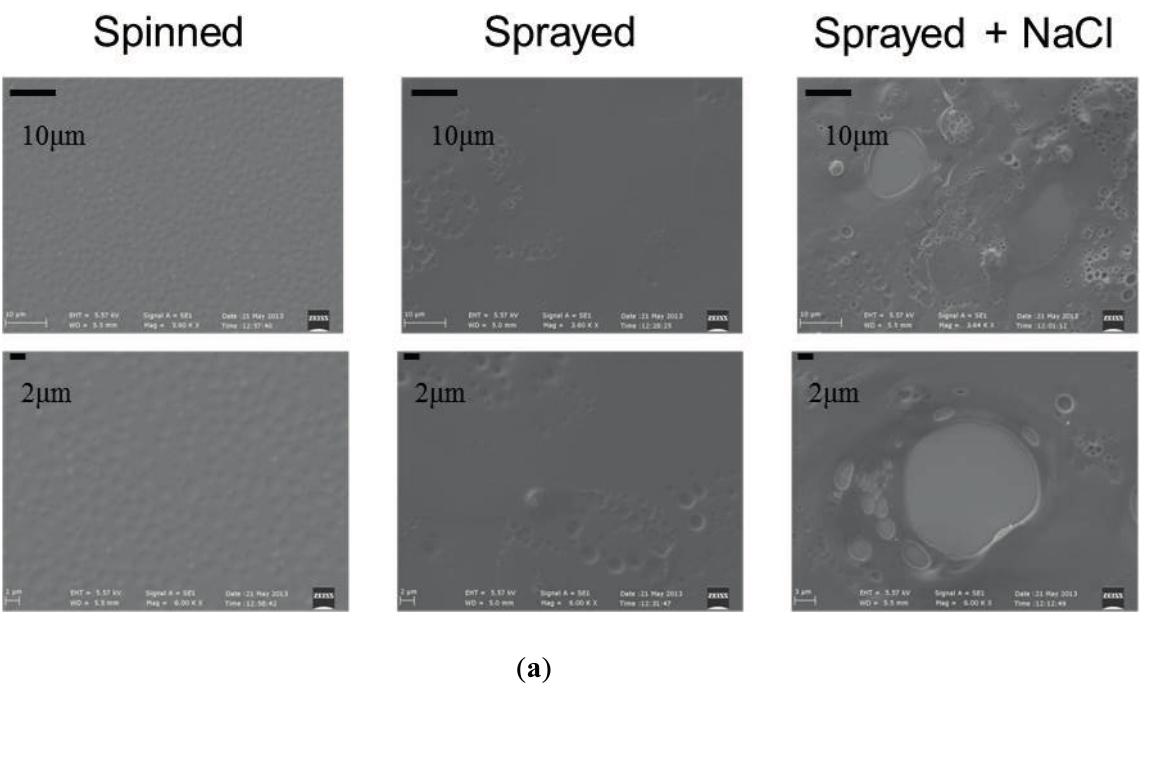
Figure 10. ( a ) SEM images of the different samples; ( b ) Left: AFM profile scans (one sample for each sample type) of a 100 × 100 μ m area. The chromatic scales refer to sample heights. Right: 3D representations, corresponding to the 2D